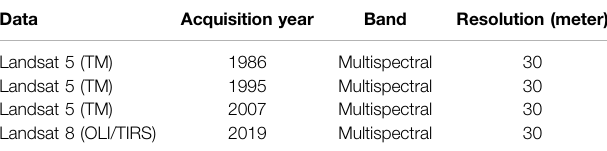
TABLE 1 | Landsat series Surface Re fl ectance data in each